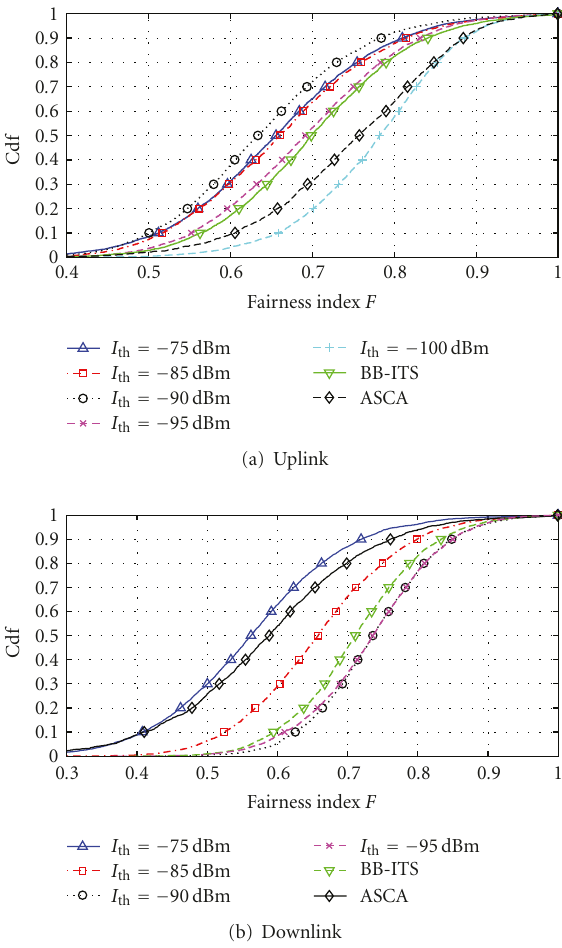
Figure 7: Mean user throughput versus distance from the serving BS, d , for BB-OFDMA with 16-QAM modulation for di ff er- ent interference thresholds I th . For comparison, results for full- frequency reuse without interference protection termed ASCA are also included. Note that at d = 115m, links are exposed to strong LOS interference (data in downlink, BB in uplink) from cells in perpendicular streets, which compromises throughput, while at d = 345m, the MSs are connected to the BS in a perpendicular street due to better channel gains.